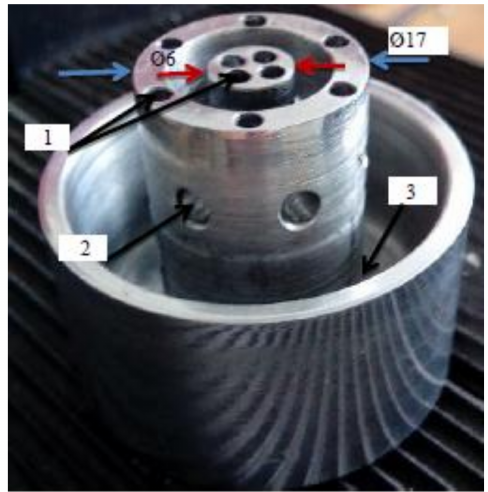
Figure 9. Photo of the collector. 1: openings for collection of the microparticle phase; 2: openings for collection of the suspension phase; 3: volume of the suspension phase.